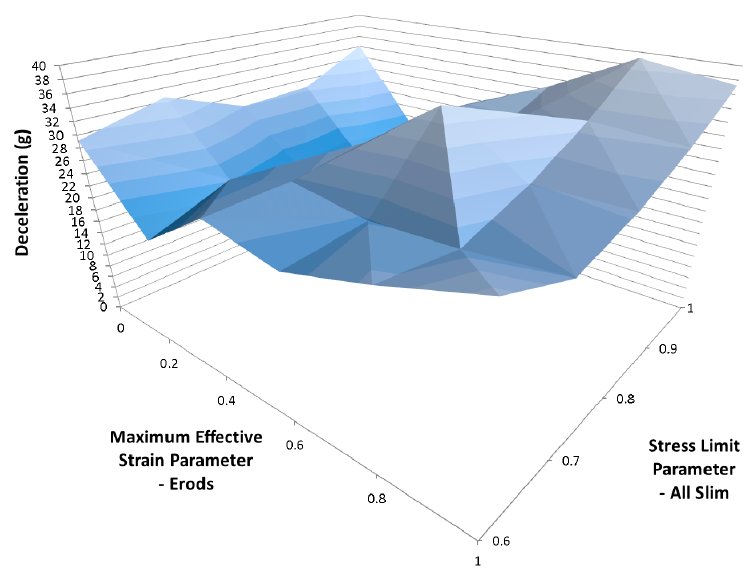
Figure 24. Effect of Erods and Slim factors with T Size = 1 × 10 − 9 , Soft = 1.0 and FS = − 1.0.